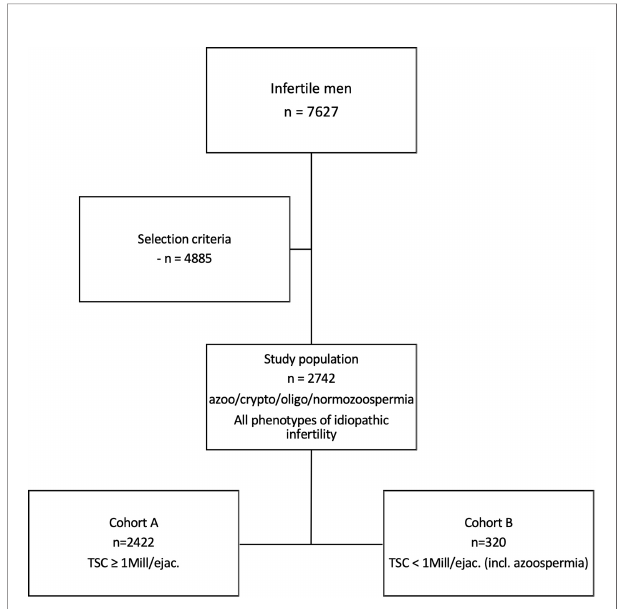
FIGURE 1 | Selection of study population of idiopathic infertile men. In a retrospective query of our database with a ten-year perspective, 7627 infertile men were selected. After applying strict selection criteria, 2742 men with idiopathic infertility were identi fi ed. The entire study population includes all phenotypes of idiopathic male infertility, ranging from azoo- to normozoospermia. Cohort A, being a sub-cohort, includes n=2422 men with a total sperm count (TSC) ≥ 1 mill/ejac. Cohort B (n=320) comprises men with TSC <1 mill/ejac. in whom (m)TESE had been